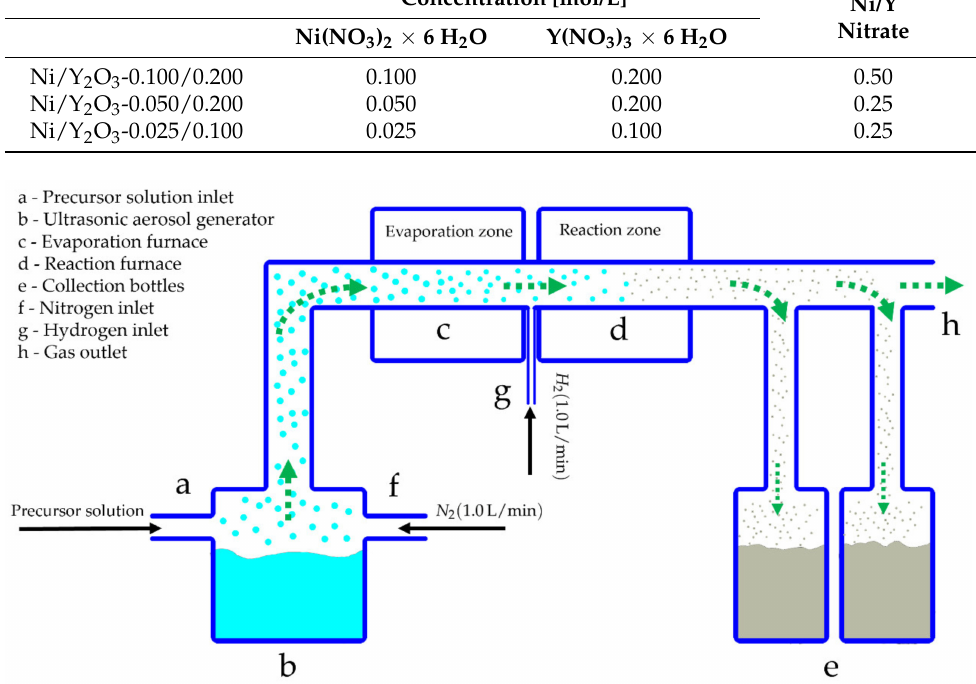
Figure 1. Schematic presentation of the USP